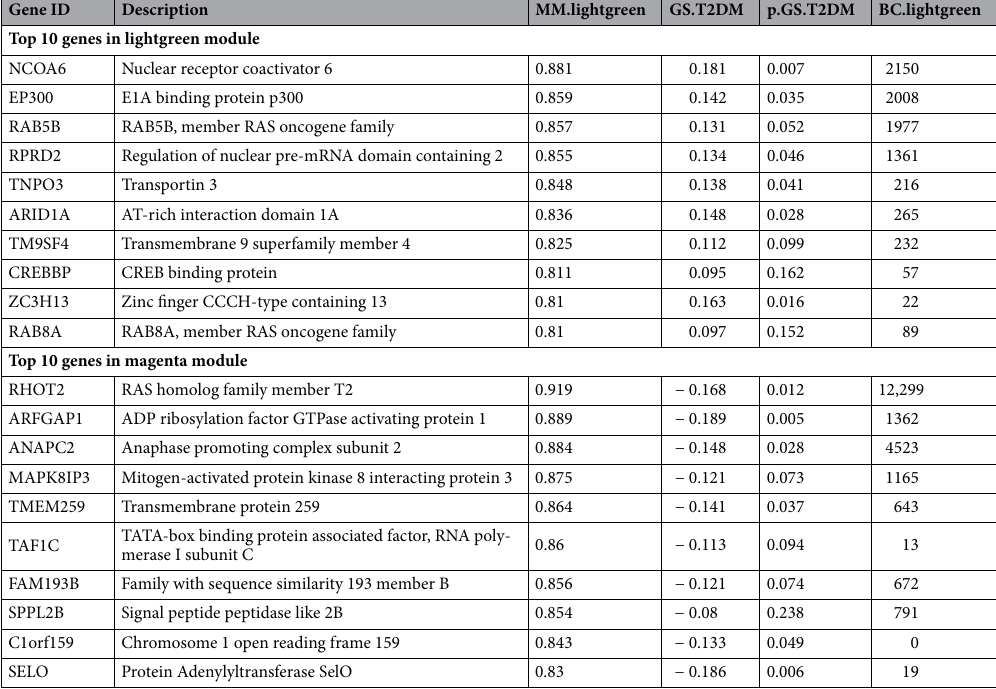
Table 1. Top 10 genes in lightgreen and magenta